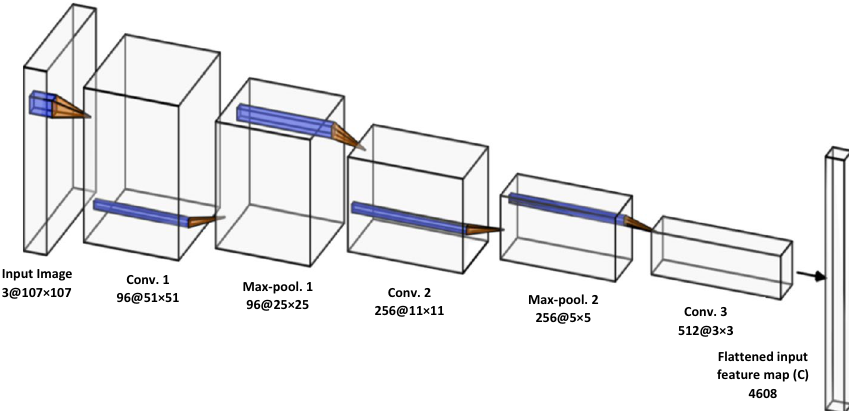
Fig. 2 The architecture of the feature extraction